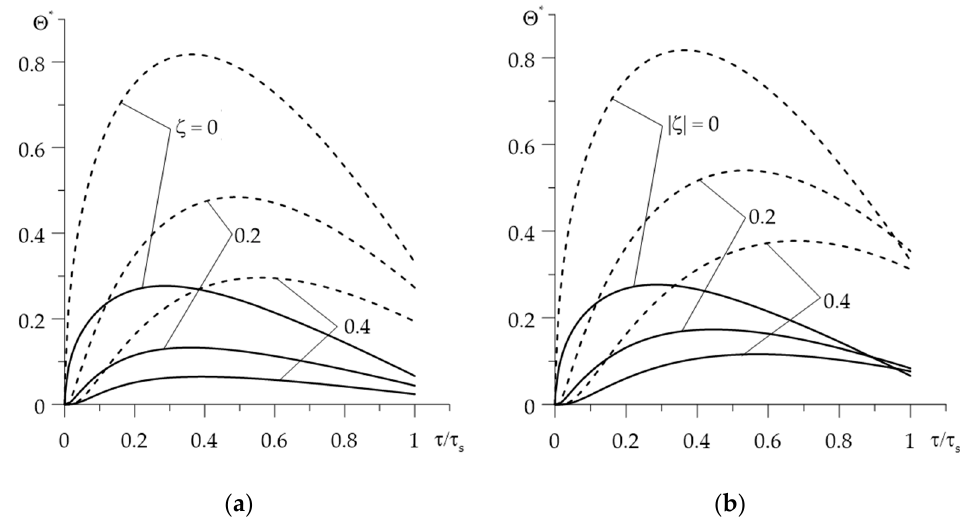
Figure 4. Evolutions of the dimensionless temperature Θ ∗ ( ζ , τ ) during braking at different distances ζ from the surface of friction with (solid lines) and without (dashed lines) taking into account the thermal sensitivity of the materials: ( a ) Al 2 O 3 —Cu; ( b ) ZrO 2 —Ti-6Al-4V. 0 =ζ , the temperature level of both